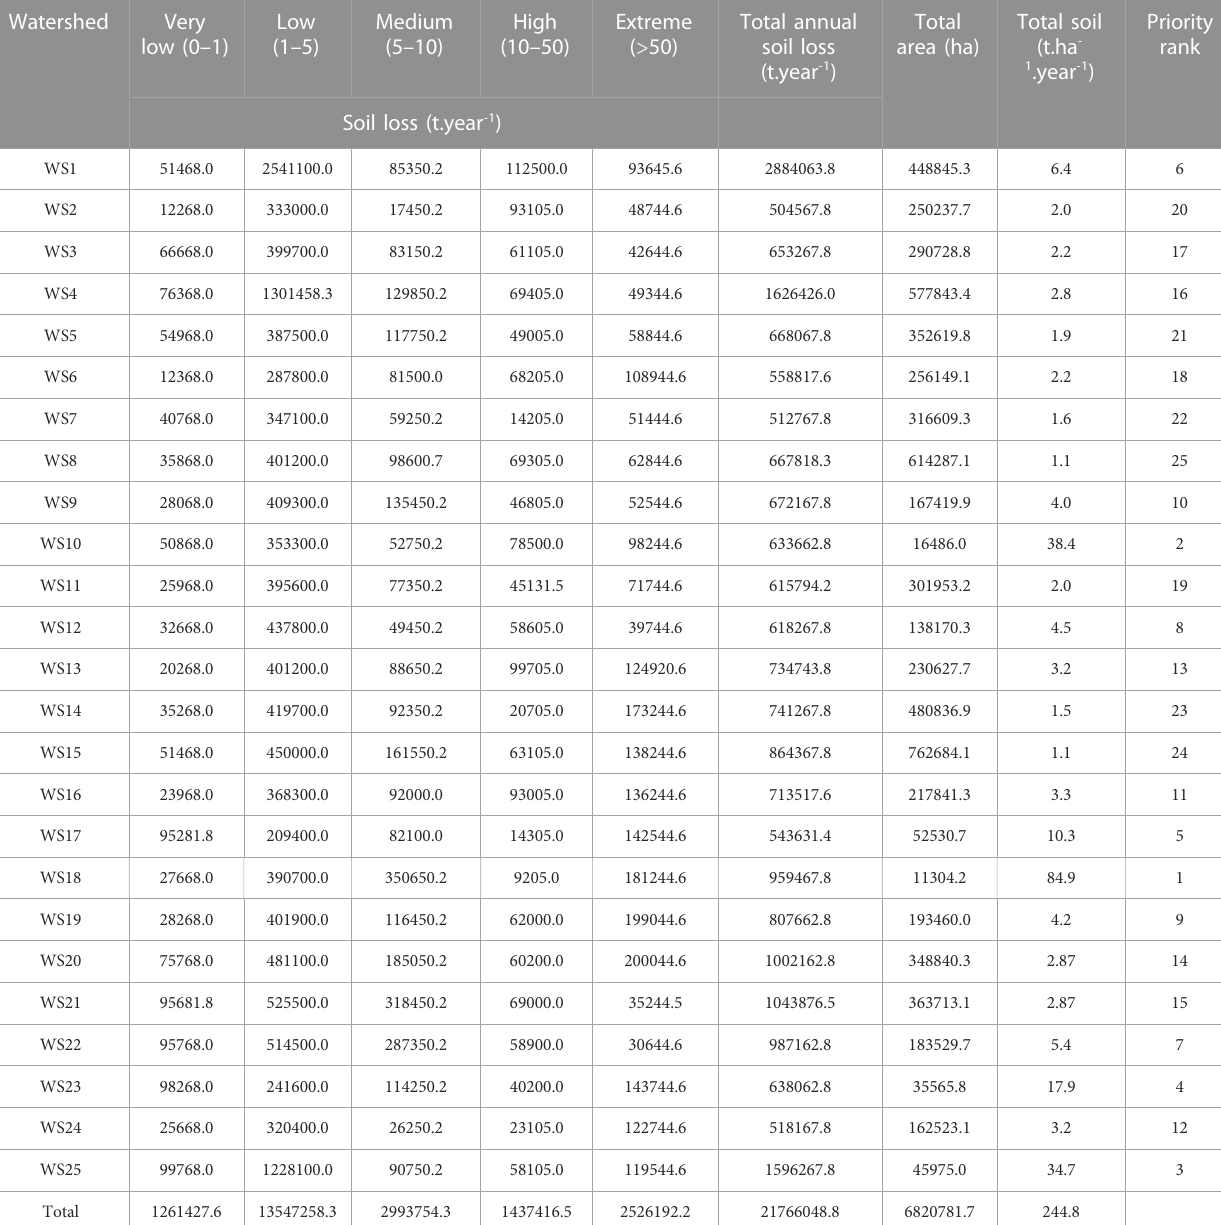
TABLE 6 Soil loss under different severity classes and priority ranking of watersheds in terms of average annual soil loss.